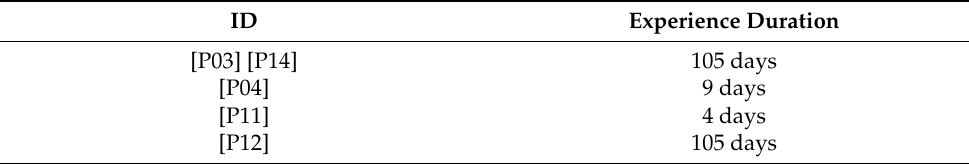
Table 14. Cost and duration of gamification experiences.